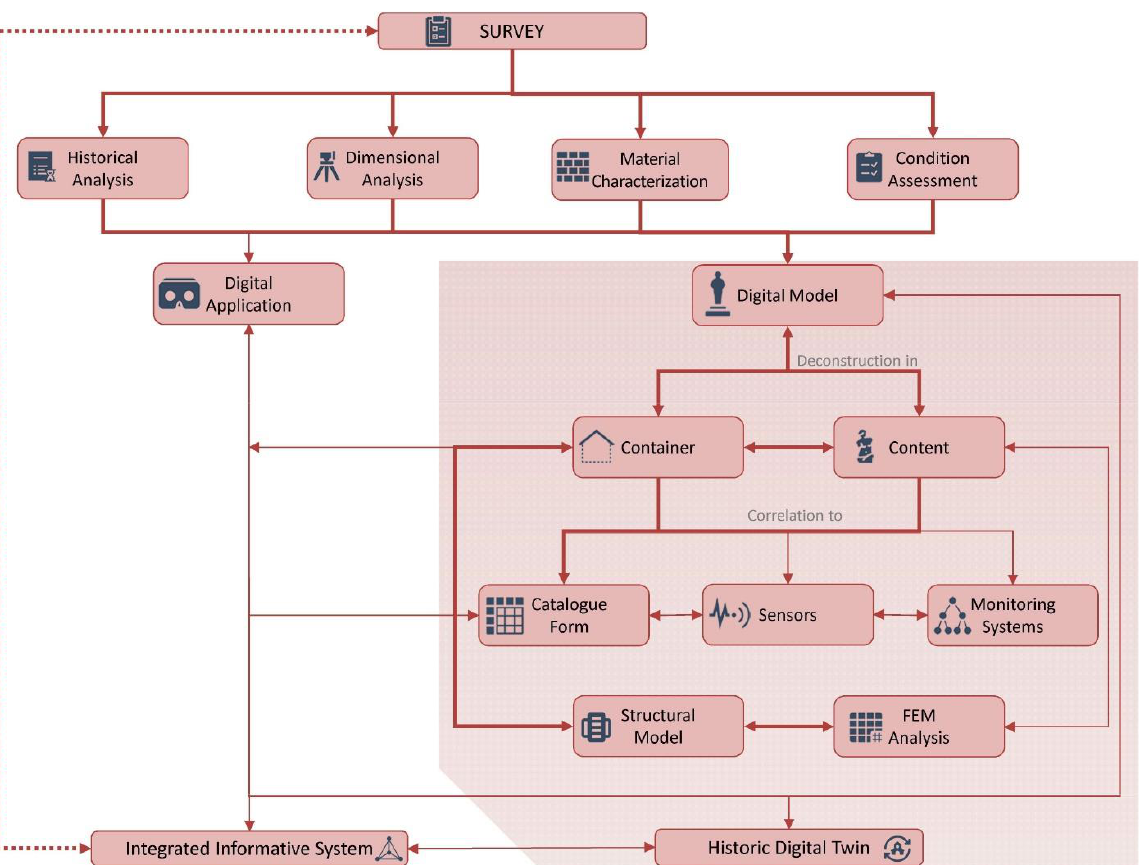
Figure 1. General framework of the research workflow.